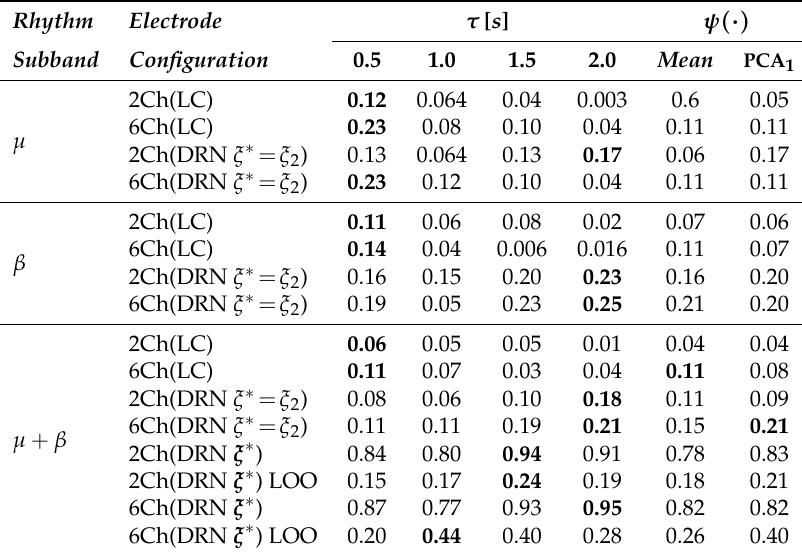
Table 2. Computed values of r for the indicator of initial training synchronization within the evaluated rhythm bandwidths: µ , β , µ + β . Notations LC, DRN, and LOO stand for Linear Correlation [40], Deep Regression Network, and leave-one-out-cross validation strategy, respectively. The best value per row is marked in